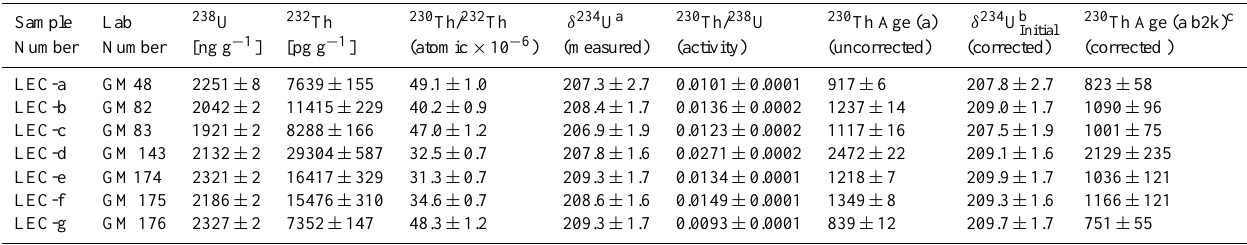
Table 1. U and Th concentrations, isotopic activity ratios and ages of coarse crystalline cryogenic cave carbonates from Leclanch´e Cave, Switzerland.